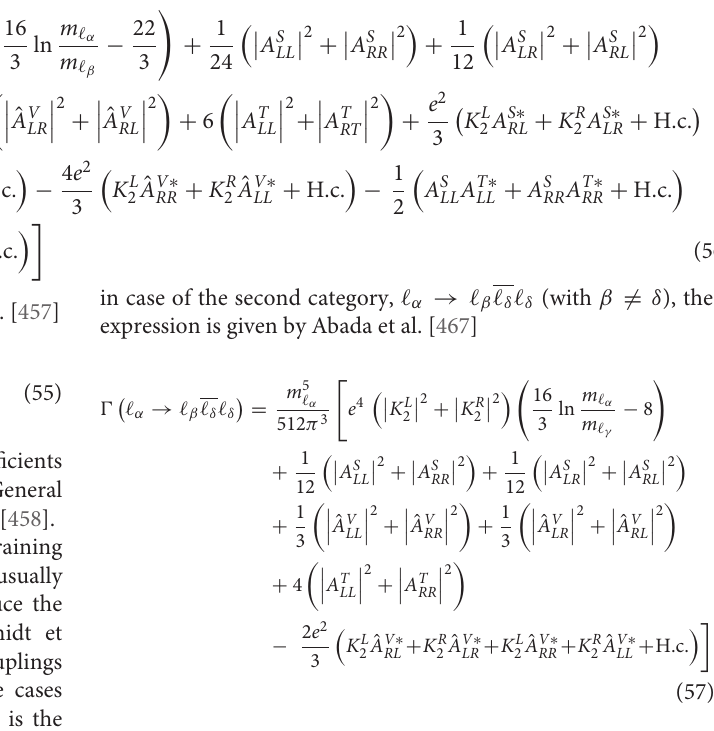
TABLE 1 | Current experimental bounds and future sensitivities for ℓ α branching ratios. LFV process